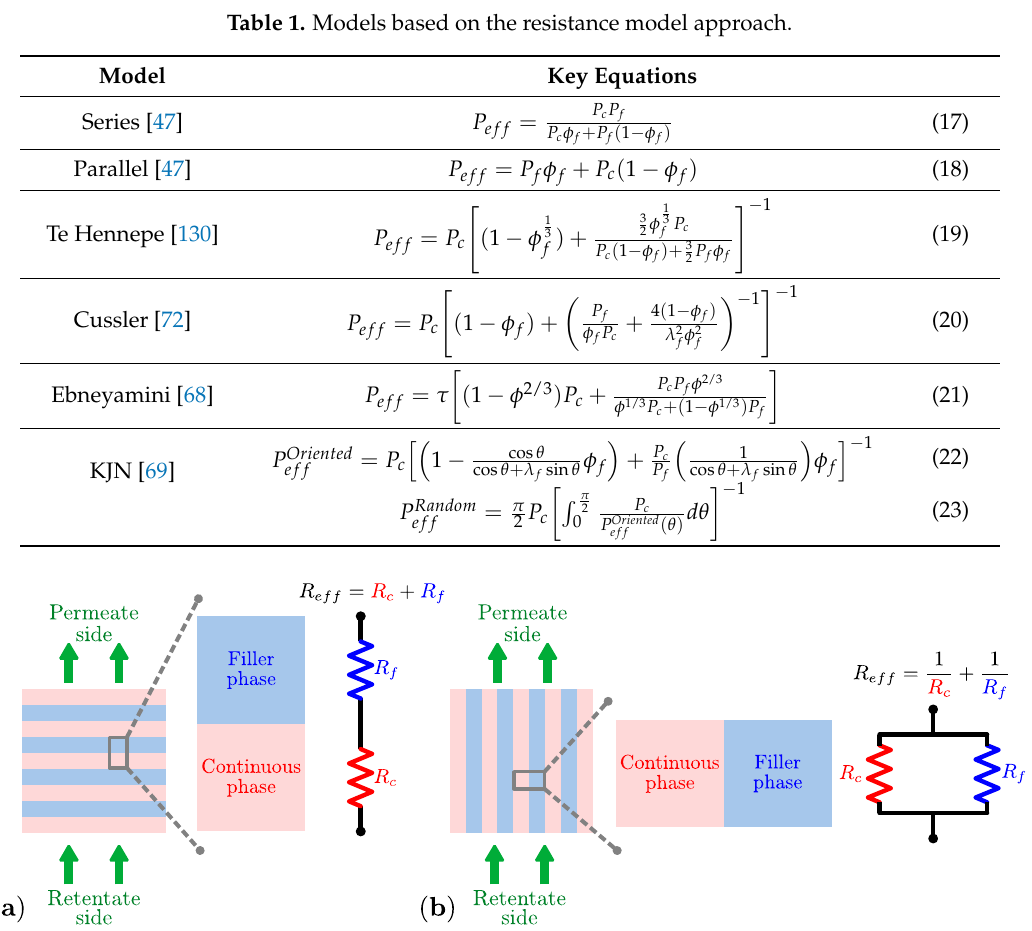
Table 1. Models based on the resistance model approach.